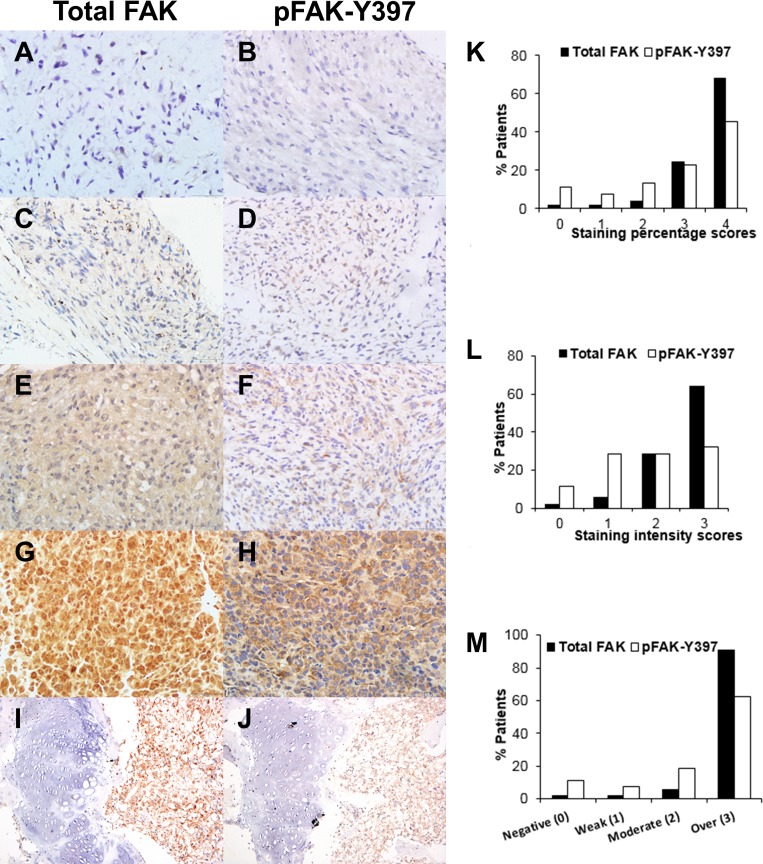
Immunohistochemical analysis of total FAK and pFAK-Y397 expression in osteosarcoma tissues.(A, B) Negative expression, (C, D) weak expression, (E, F) moderate expression, (G, H) strong expression. (I, J) Strongly diffused total FAK (I-right) or pFAK-Y397 (J-right) expression in osteosarcoma, in contrast to diminished total FAK (I-left) or pFAK-Y397 (J-left) expression in adjacent epiphyseal growth plates. Original magnifications, x400 (A-H), x100 (I, J). Analysis of immunohistochemistry of total FAK and pFAK-Y397. (K) Percentage of positive tumor cells classified into 4 categories: 0, no staining; 1, < 25%; 2, 25–49%; 3, 50–74%; 4, 75–100%. (L) Staining intensity of positive tumor cells: 0, none; 1, weak; 2, moderate; 3, strong. (M) Overall score for total FAK or pFAK-Y397 expression in patients with osteosarcoma. The scores from staining percentage and intensity were added to yield the overall scores of 0, negative; 1–2, weak; 3–4, moderate; 5–7, overexpression.